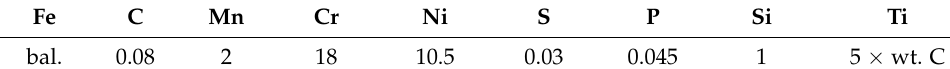
Figure 1. Illustration of the samples employed in plastic straining. Table 1. Chemical composition of the 321 austenitic stainless steel (wt. %).